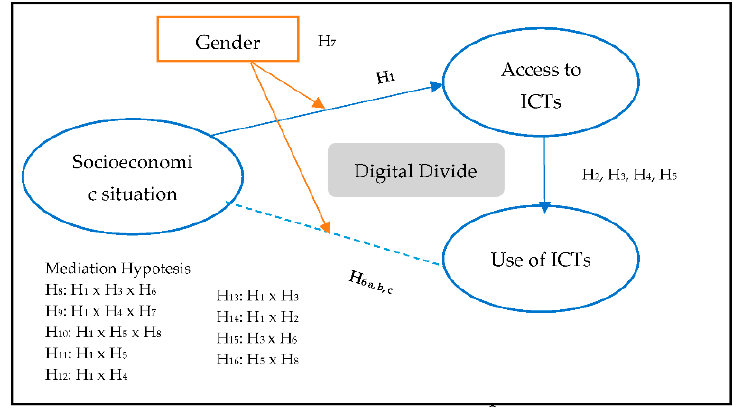
Figure 1. Research Model. Source: Own elaboration.